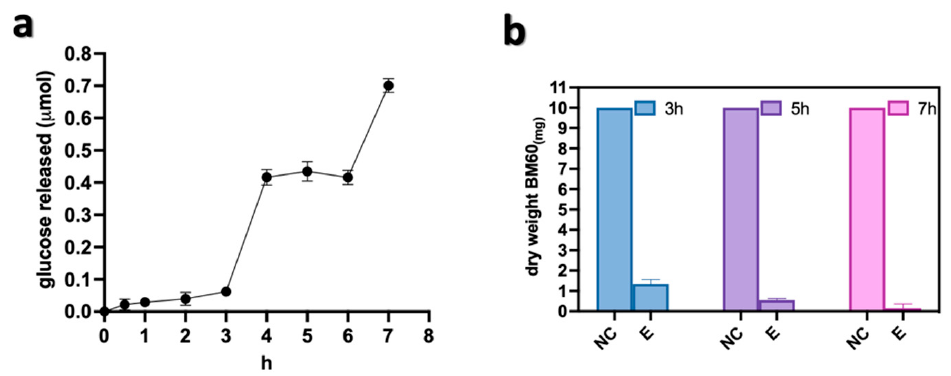
Figure 4. Time course of the enzymatic digestion on BM60 sample. ( a ) Kinetic curve of released glucose and ( b ) dry weight measurements of the residual cellulose. NC: negative control (without Cellic Ctec2) and E: with Cellic Ctec2.